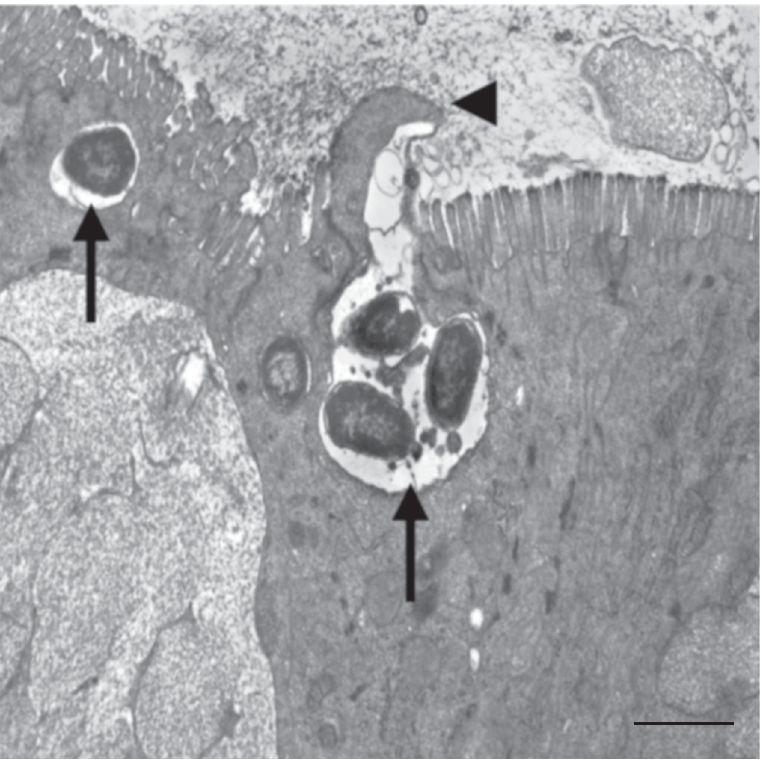
Figure 1. Transmission electron micrograph showing invasion of bovine enterocytes in the Peyer’s patches by Salmonella typhimurium . Intracellular bacteria are located within mem- brane bound vacuoles (arrows). Bacteria being internalized by cytoplasmic projections of the apical surface of the enterocyte (arrowhead). Bar = 1